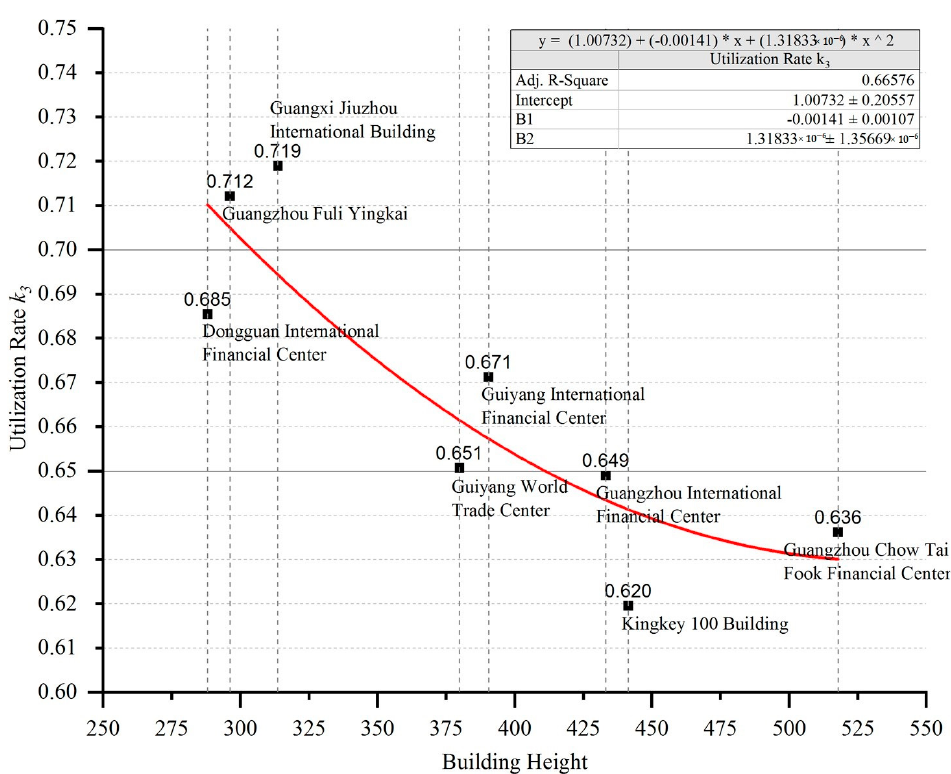
Figure 27. Relationship between the number of refuge/equipment floors and the building area of refuge/equipment floors.